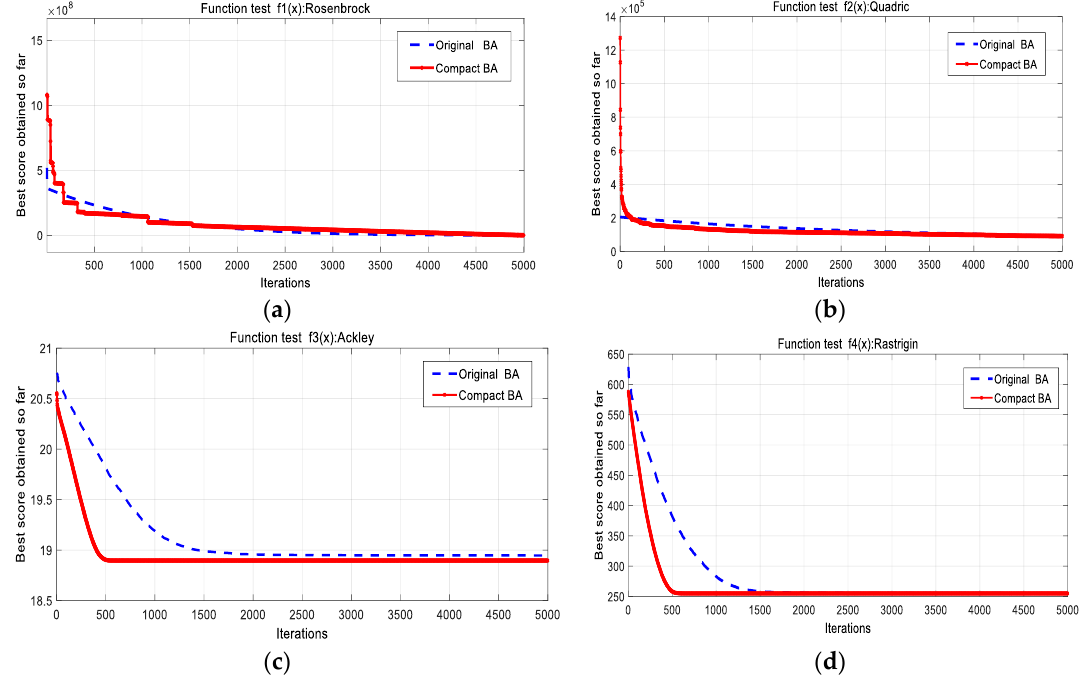
Figure 1. Convergence comparison of two algorithms of cBA and oBA for four first test functions. ( a ): Rosenbrock function; ( b ): Quadric function; ( c ): Ackley function; ( d ): Rastrigin function.